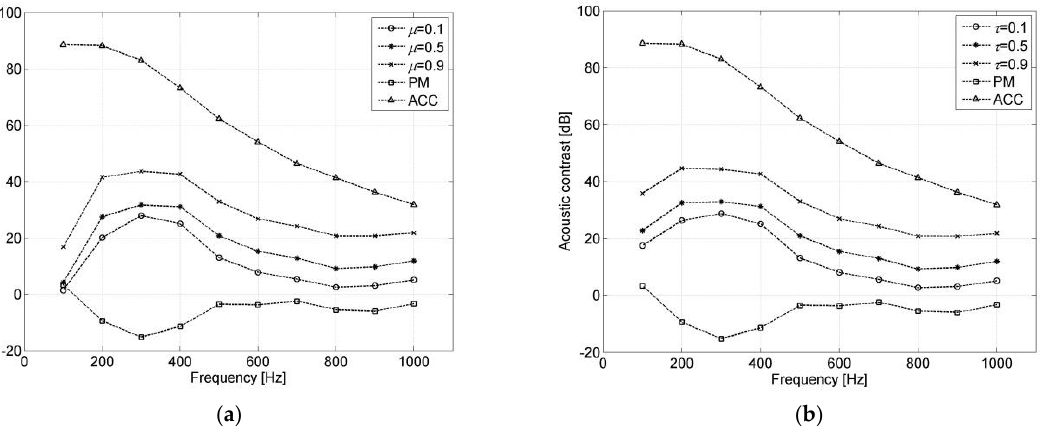
Figure 7. Acoustic contrast of different methods for three-dimensional experiment. ( a ): PM method in bright zone, ACC method, the first proposed method with µ = 0.1, 0.5 and 0.9; ( b ): PM method in bright zone, ACC method, the second proposed method with = 0.1, 0.5 and 0.9. Table 6. Average acoustic contrast of different methods relative to frequency for three-dimensional experiment.